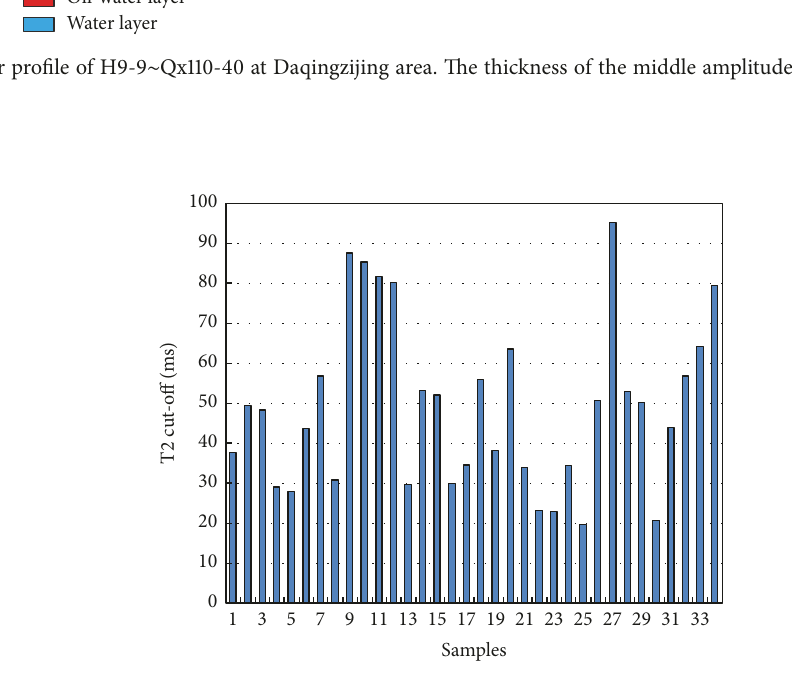
Figure 12: T2 cut-off value and irreducible water saturation distribution in the area of Daqingzijing.